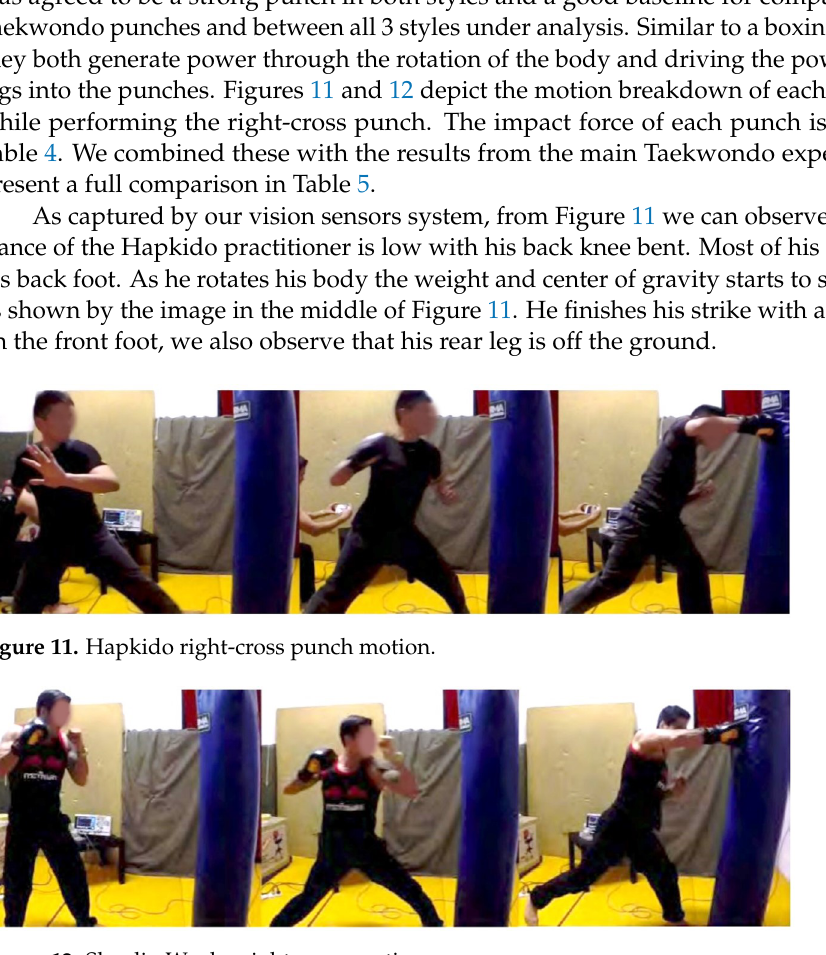
Figure 12. Shaolin Wushu right-cross